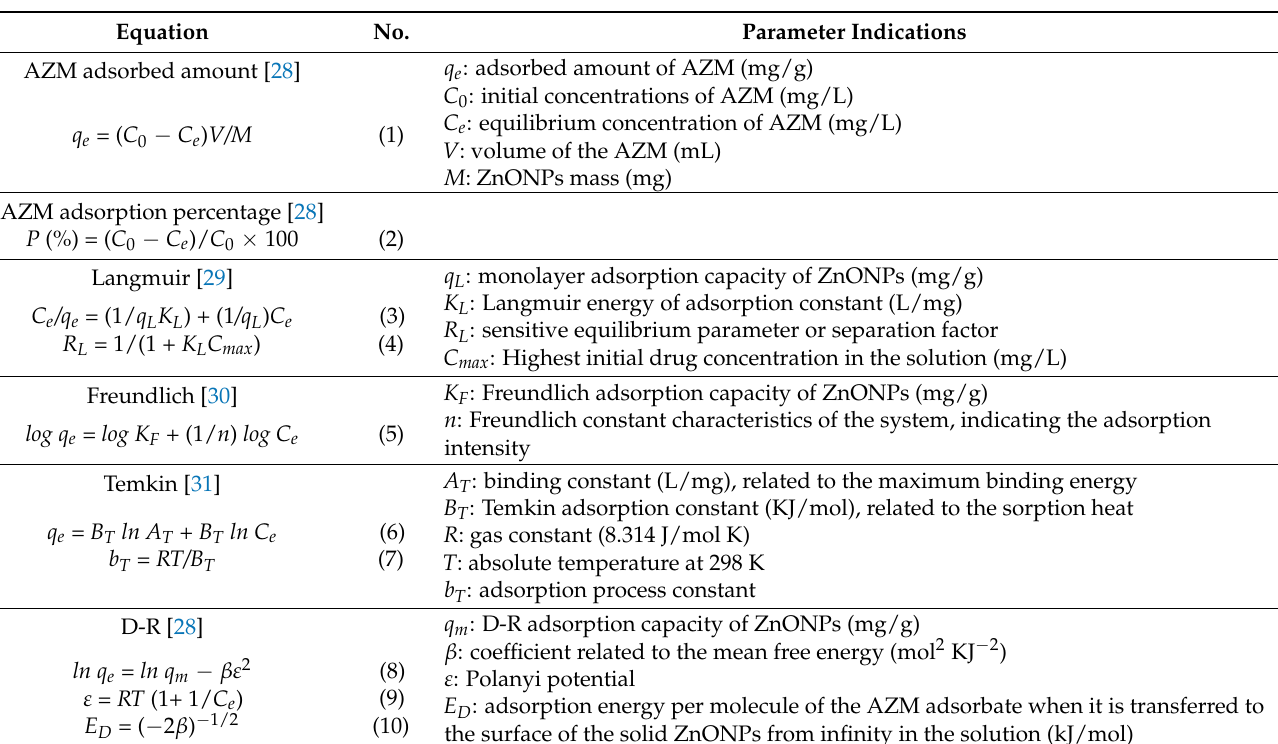
Table 1. Different equations of the isothermal models implemented for the investigation of the adsorption process of AZM using